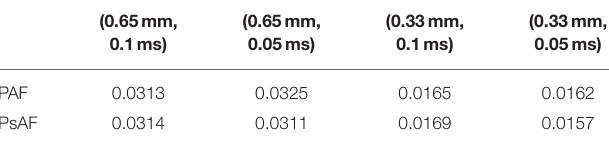
TABLE 1 | Relative error err ( h , 1 t ) in approximating the activation time for different choices of ( h , 1 t